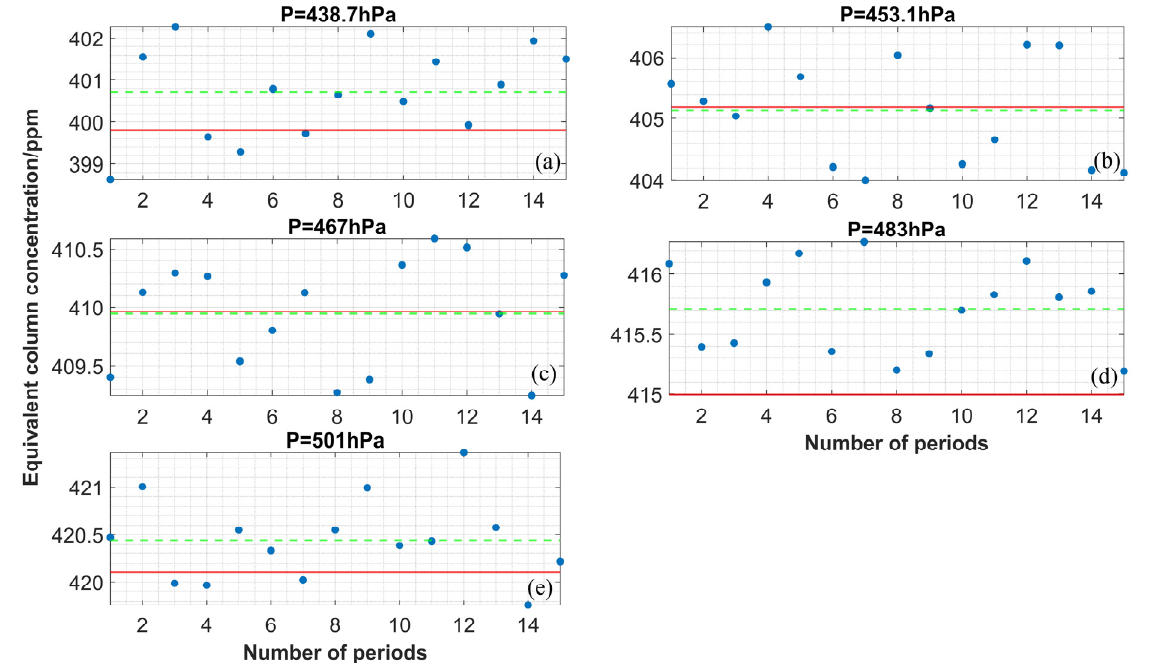
Figure 13. The retrieval results of 15 periods at ( a ) 438.7 hPa; ( b ) 453.1 hPa; ( c ) 467 hPa; ( d ) 483 hPa; ( e ) 501 hPa, respectively. The actual retrieval results (blue dot), averages of retrieval results (green dotted-line) and true values (red line) are shown. Table 8. Comparison of retrieval results.